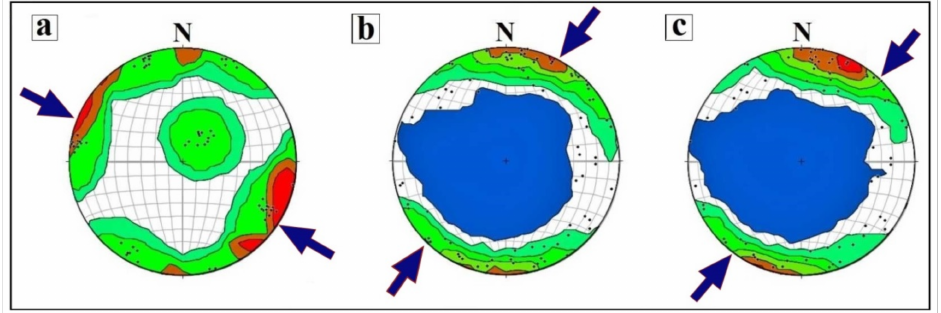
Figure 11. The σ 1 orientations of density stereo plots for three paleostress fields were obtained: ( a ) late Cretaceous, ( b ) Eocene, and ( c ) Quaternary. The 1% contour intervals are represented in the southern hemisphere with equal-area